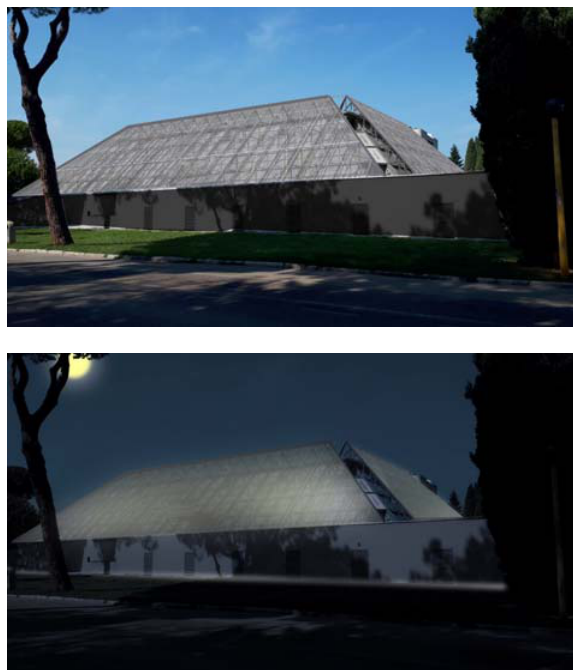
Figure 10. Simulation of the chromatic requalification and the insertion of the micro-perforated sheet.